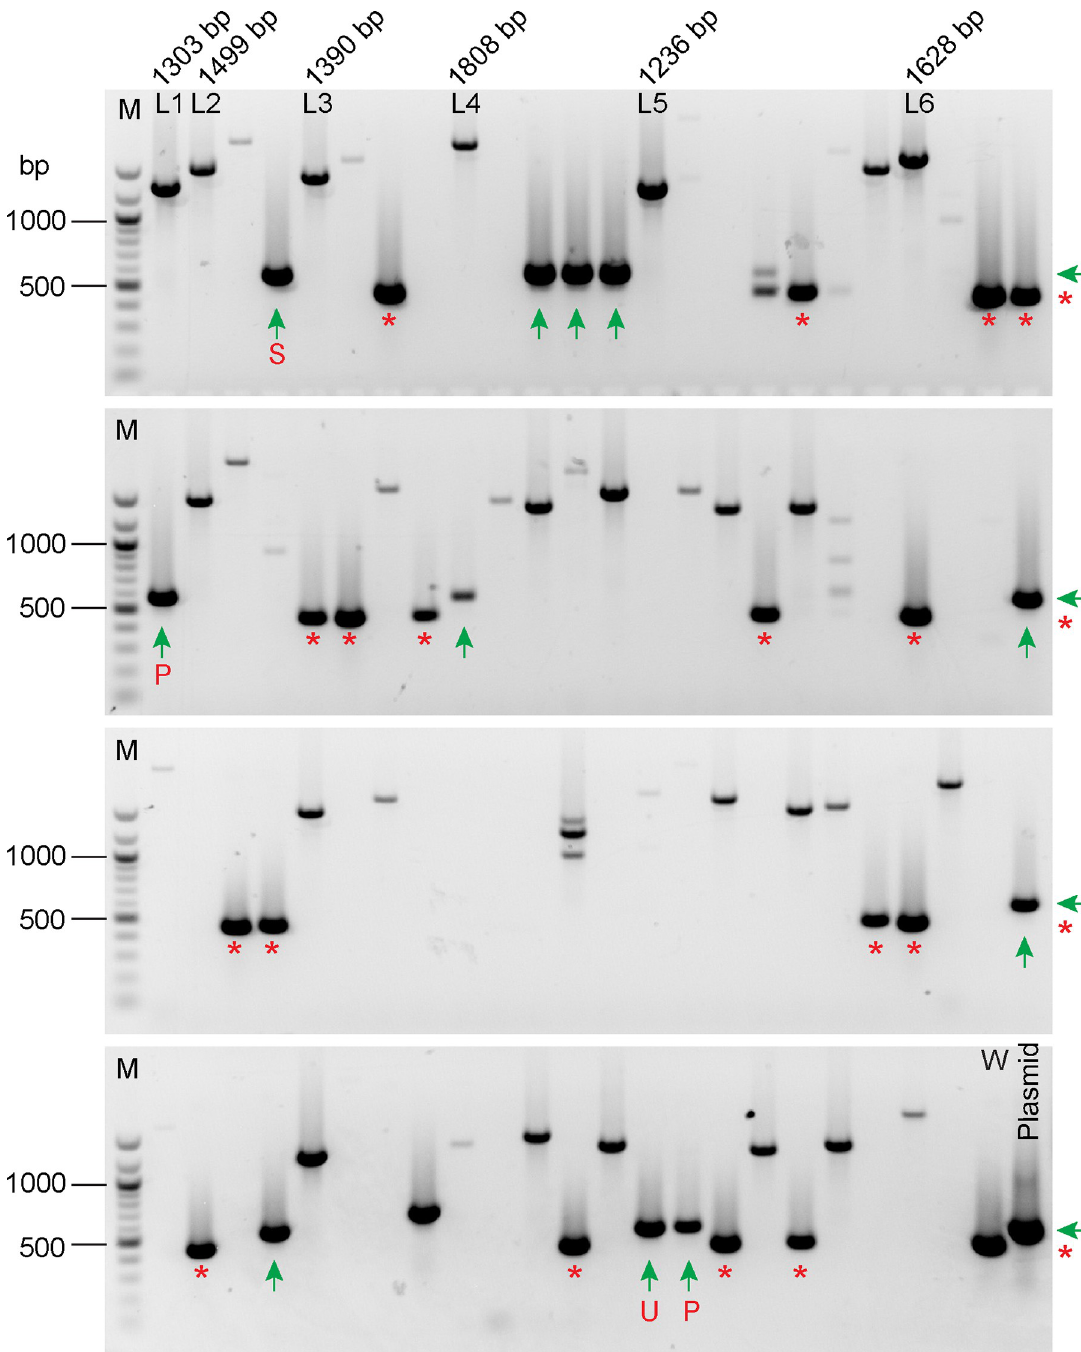
Fig 5. Initial PCR screening of transformants from the LF5-HA C-terminal tagging experiment. DNA from the wild-type strain (W), 94 transformants, and the plasmid pLF5HA, which contains the LF5-HA gene, were used as templates for PCR screening with primer pairs P1 and P2 as illustrated in Fig 2. The expected size for the wild-type product was 455 bp (marked with red � on the right side of the gels and below the bands). In theory, one small fragment (563 bp) and one large fragment (3576 bp) would be predicted as products resulting from PCR amplification of the tagged gene in this experiment, yet only the small fragment was observed (marked with green arrows on the right side of the gels and below the bands). There are several likely reasons for this. First, we used a PCR elongation time optimal for 563-bp products, so there would not have been enough time for the polymerase to amplify products as large as 3576 bp. Second, to facilitate screening of a large number of clones, we used crude DNA as template, and in our experience it is more difficult to amplify longer PCR products from crude DNA. Third, due to the high GC content of C . reinhardtii DNA, it is harder to